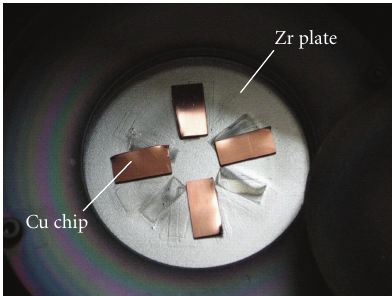
Figure 1: Photograph of elemental composite target used in this study (Cu chips on Zr disk